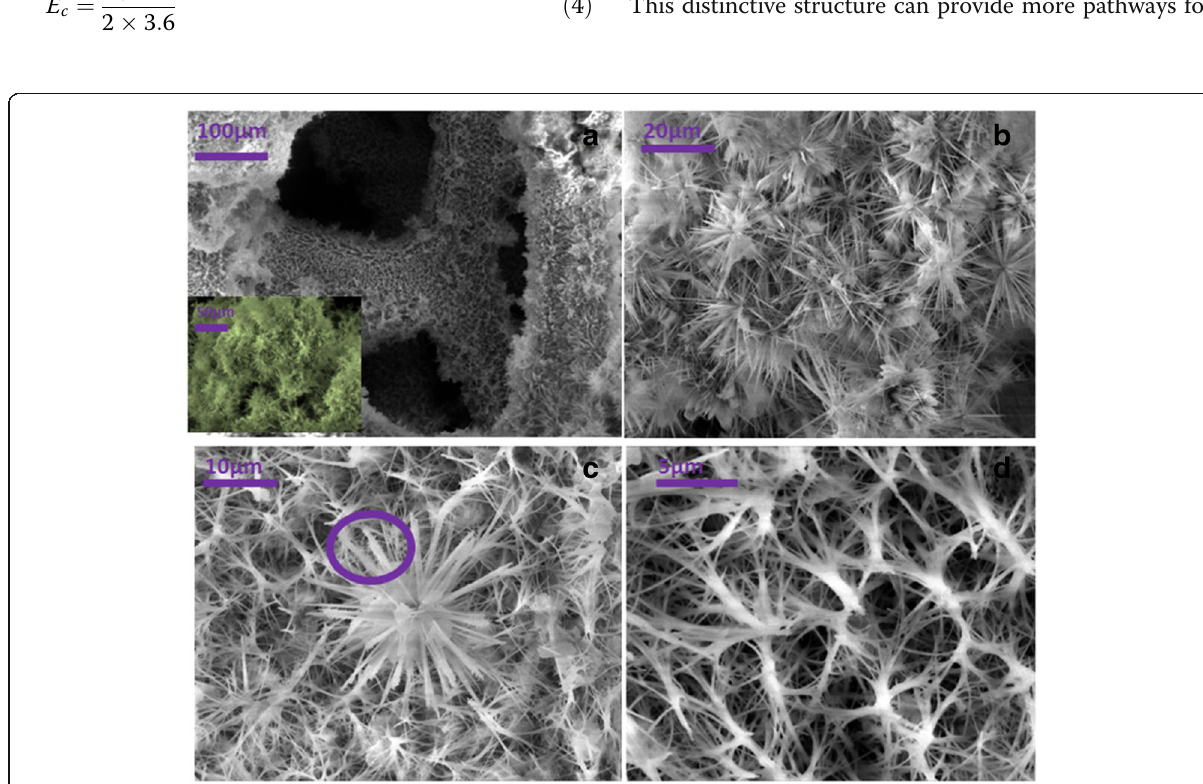
Fig. 1 a Layered structure of nickel foam (the illustration shows the material attached to the nickel foam). b The appearance of the